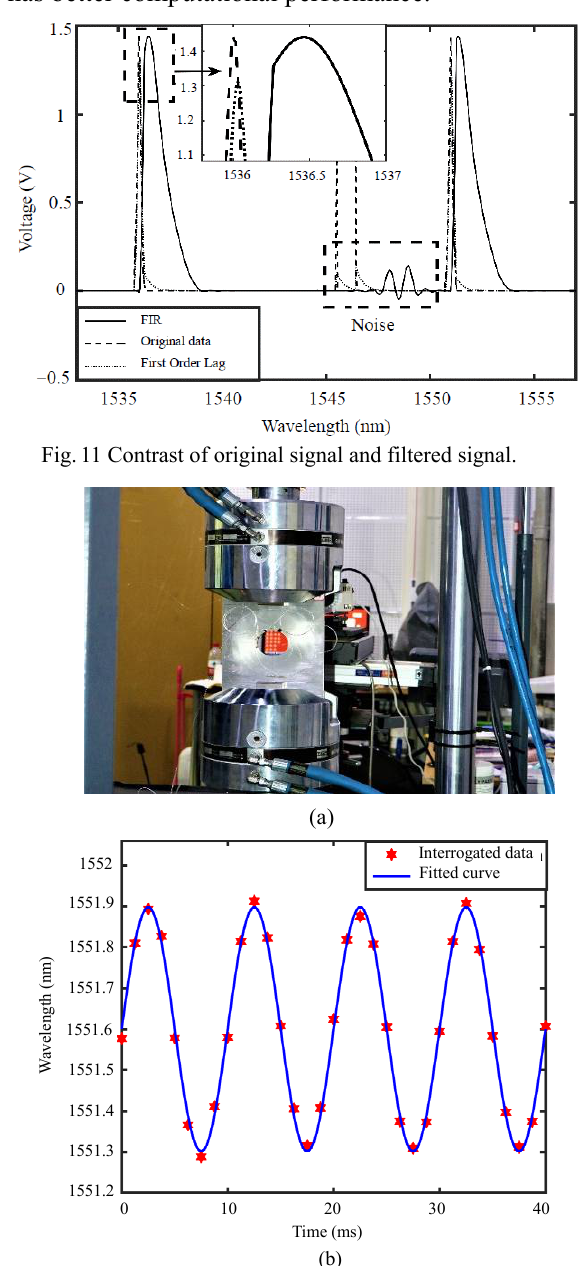
(b) Fig. 12 Device and monitoring results of dynamic experiment: (a) the experimental device and (b) the experimental